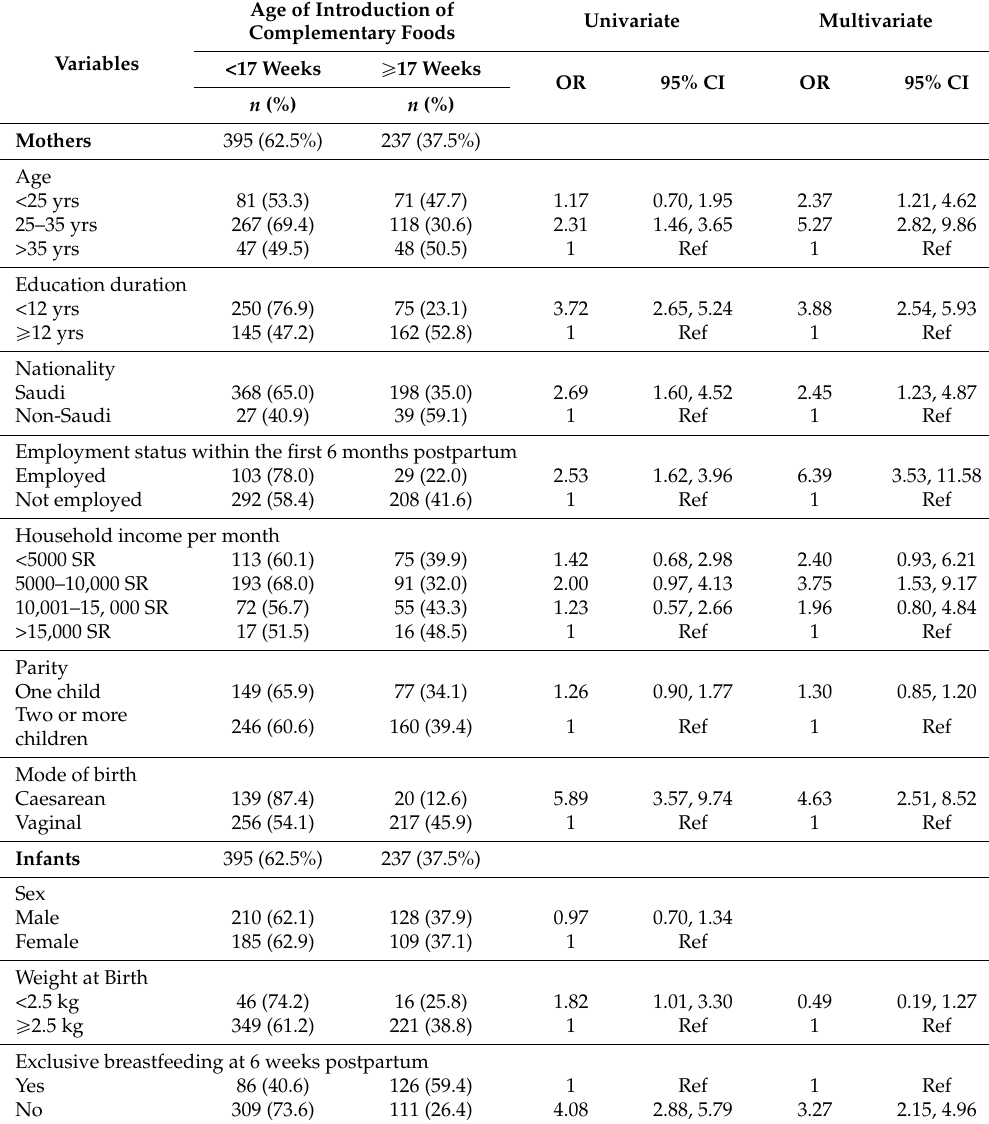
Table 3. Factors associated with the early introduction of complementary feeding ( n =